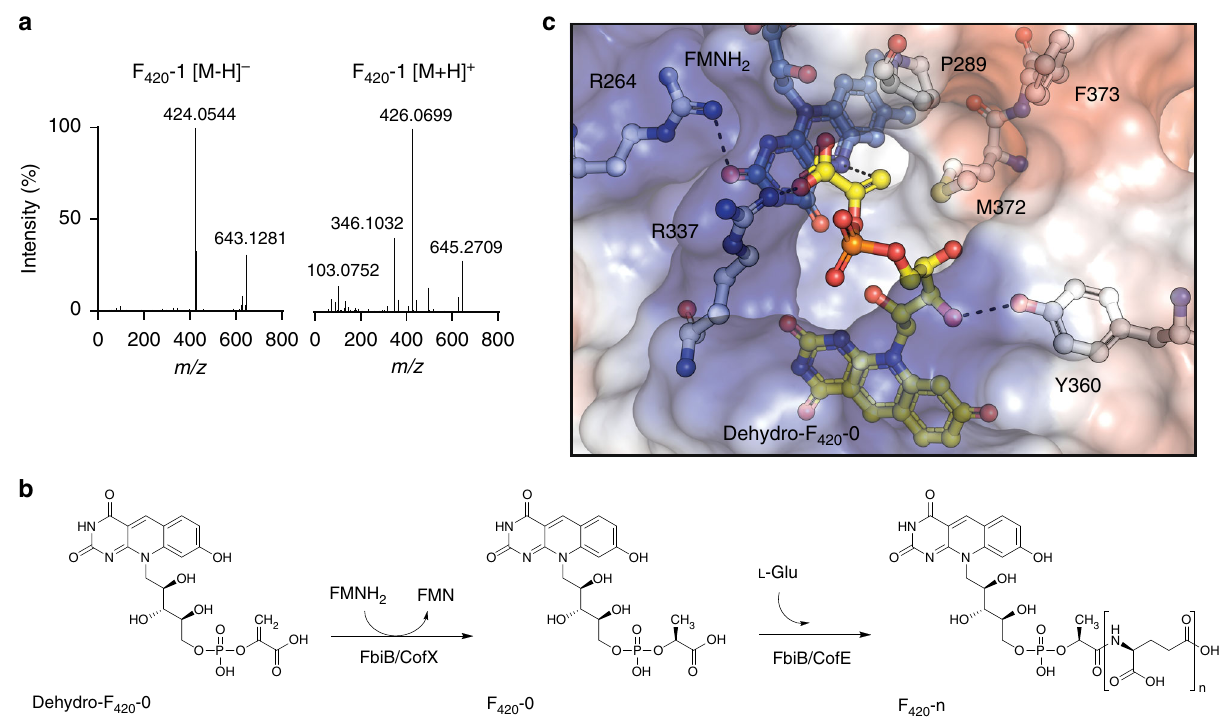
Fig. 4 Mtb -FbiB catalyzes reduction of dehydro-F 420 -0. a F 420 -1 is produced in FbiD:FbiA:FbiB coupled assays in the presence of Fre/FMNH 2 and − ) and positive (645.27094, [M + H] + ) L -glutamate. Tandem mass spectrometry (MS/MS) con fi rmation of F 420 -1 in both negative (643.12811, [M − H] modes. b Mtb -FbiB is a bifunctional enzyme catalyzing the reduction of dehydro-F 420 -0 and its poly-glutamylation to form F 420 -n. c Docking of FMNH 2 and dehydro-F 420 -0 into the crystal structure of FbiB C-terminal domain. The methylene group of the enolpyruvyl moiety sits in a pocket made up of M372 and P289, while the carboxylate hydrogen bonds with R337. The methylene double bond sits planar above the isoalloxazine ring of FMNH 2 at an appropriate distance (3.6 Å, shown by dashed line) and oriented for a hydride transfer to the Si face of the methylene bond, accounting for the observed ( S